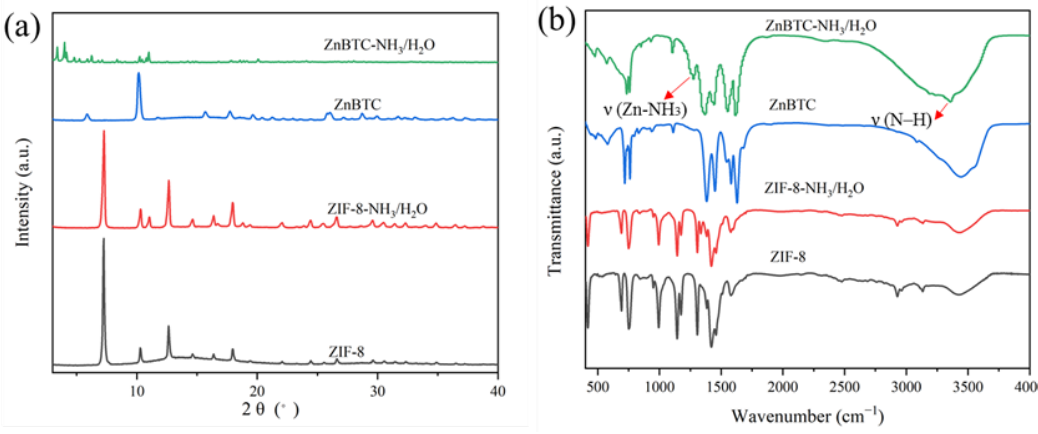
Figure 3. The XRD patterns ( a ) and FTIR ( b ) of ZIF-8 and ZnBTC.